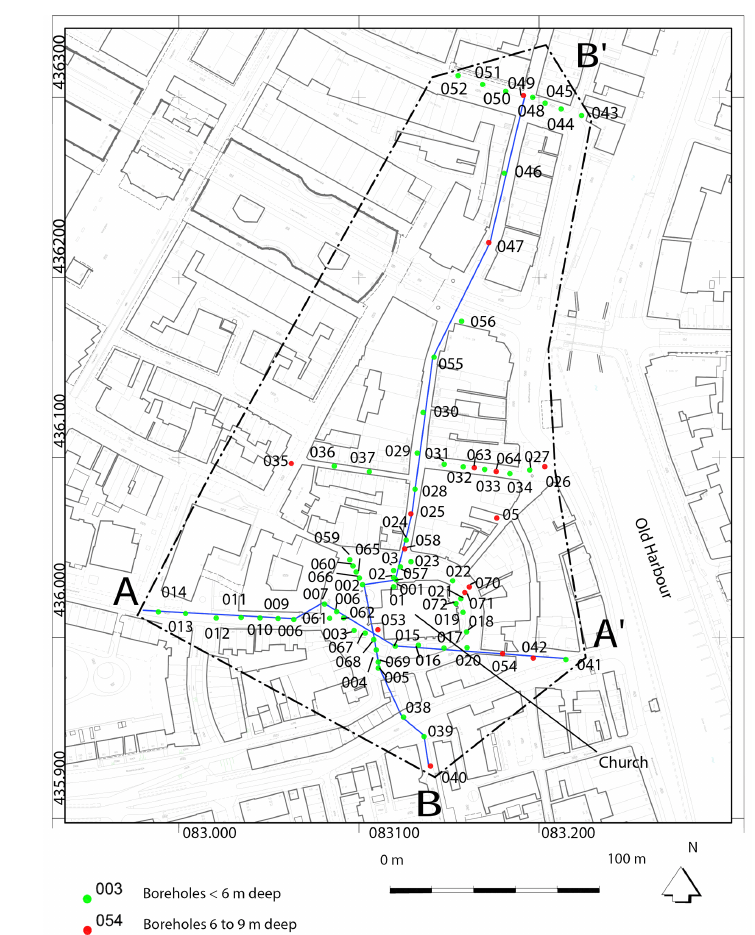
Figure 2. Study area within city centre of Vlaardingen (Stadshart) with locations of 76 mechanical cores and the position of two cross- sections A and B.